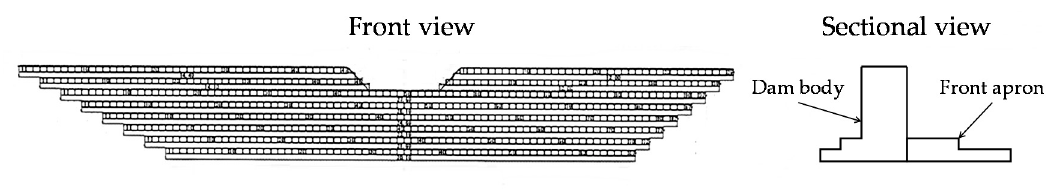
Figure 2. Front and sectional views of a timber dam [19].